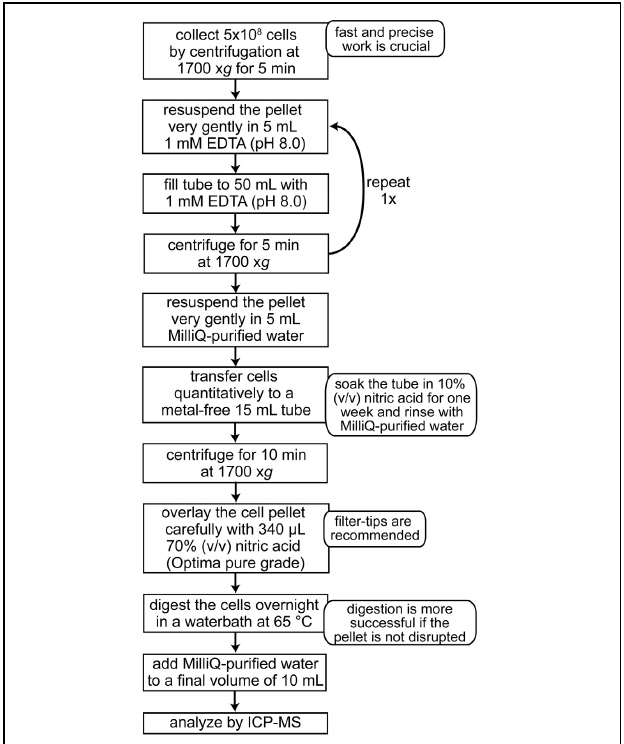
FIGURE 6 | Sample preparation of Chlamydomonas cells for metal analysis by